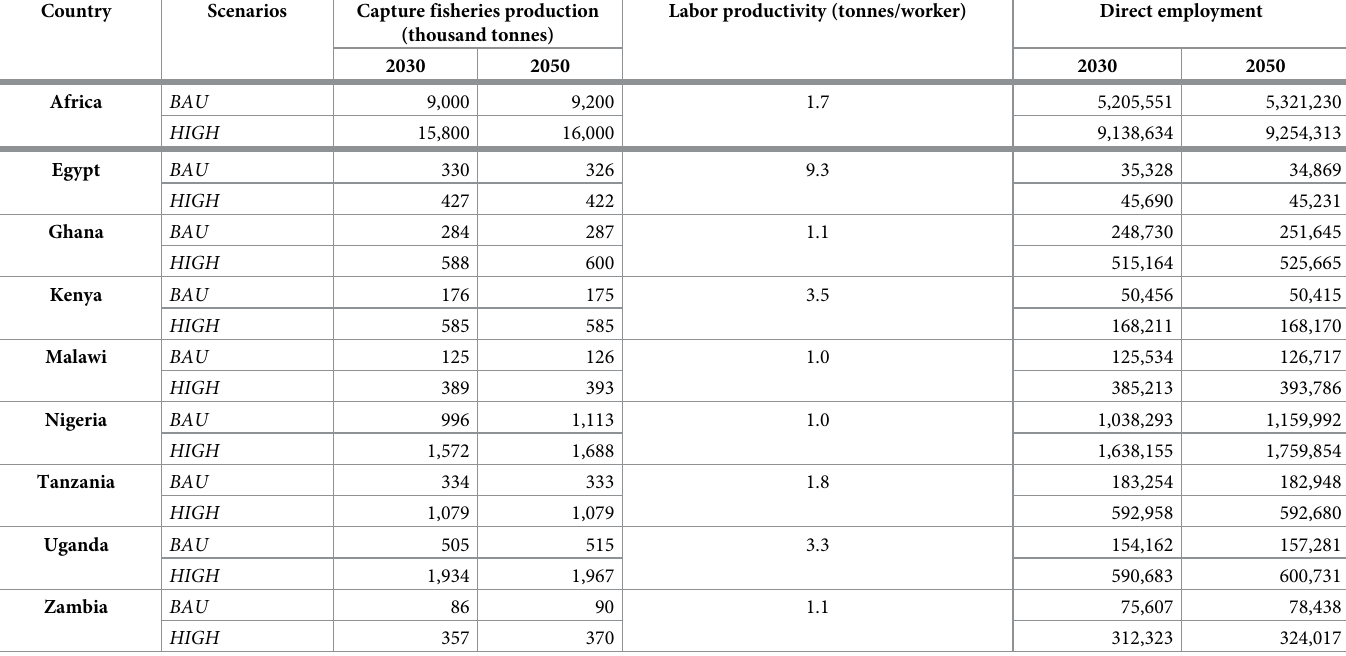
Table 6. Estimated direct employment of Africa’s capture fisheries sector for BAU and HIGH scenarios in 2030 and 2050.